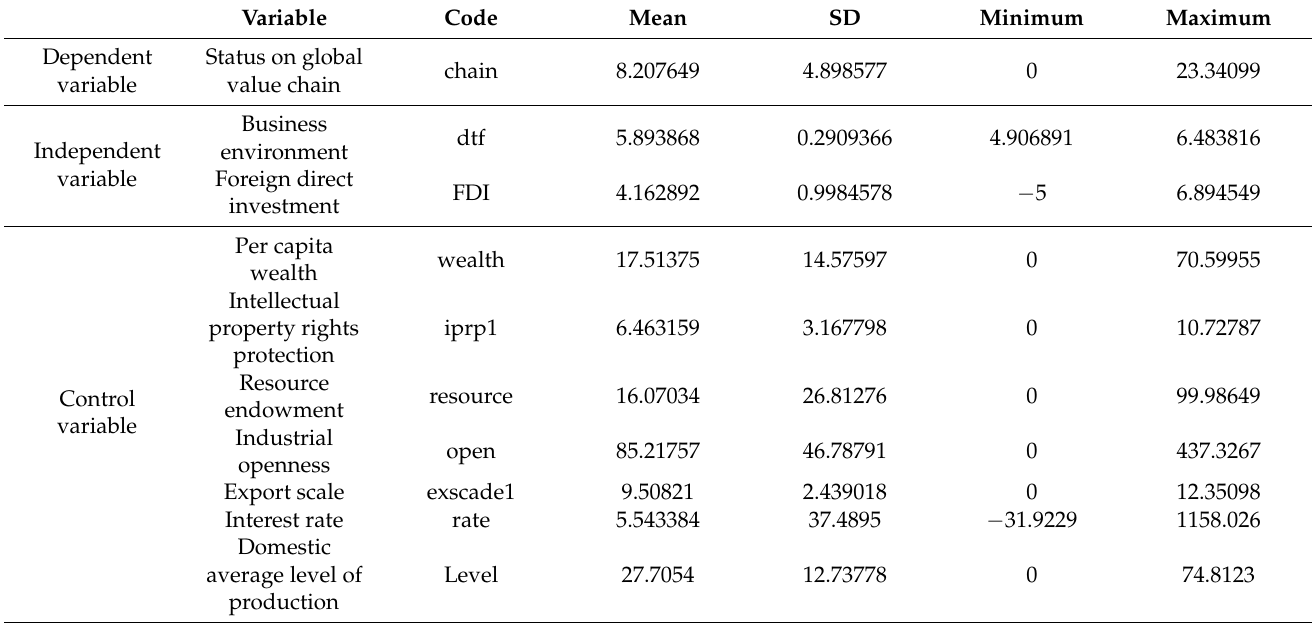
Table 1. Descriptive statistics of